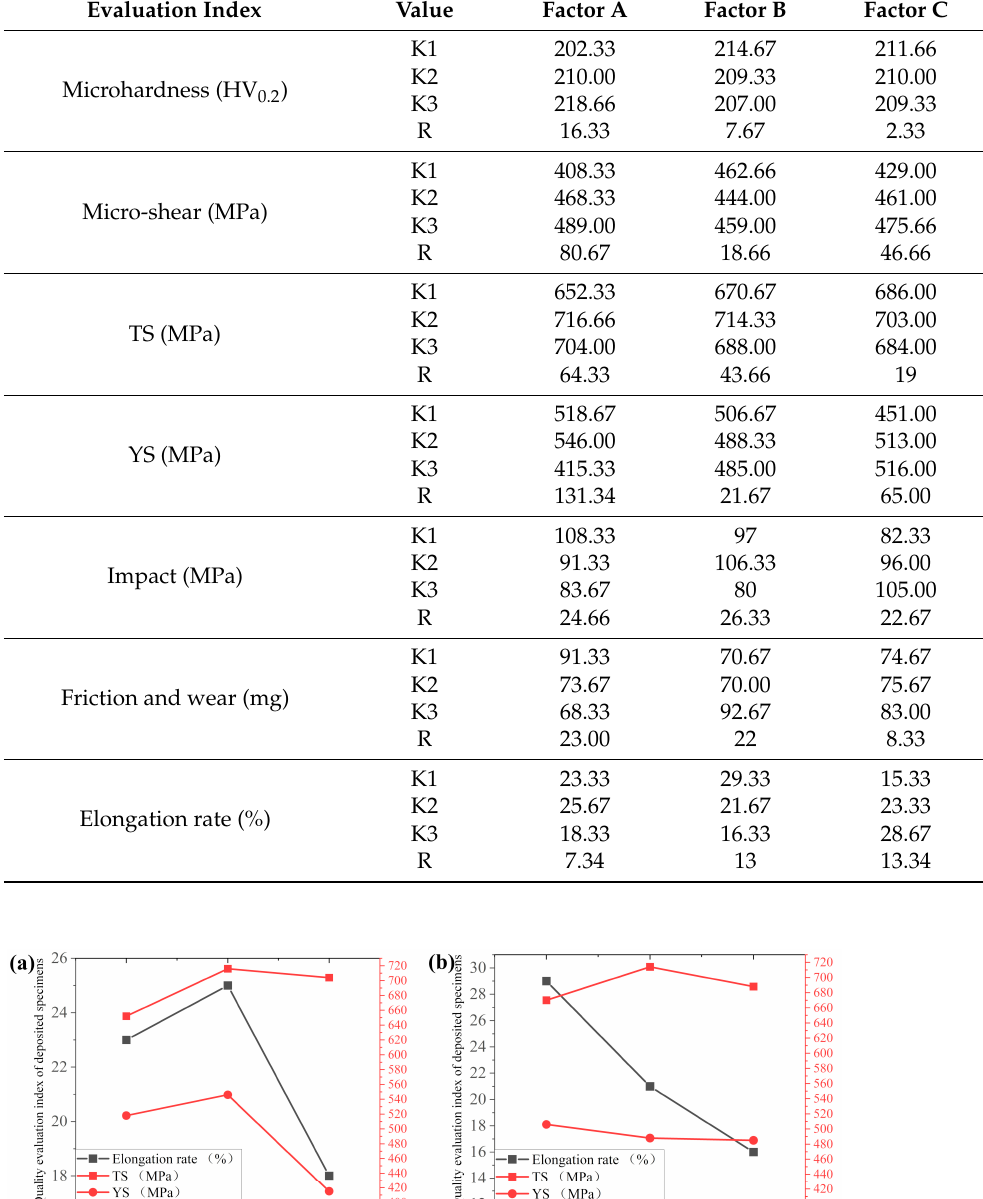
Table 7. Analysis of range.